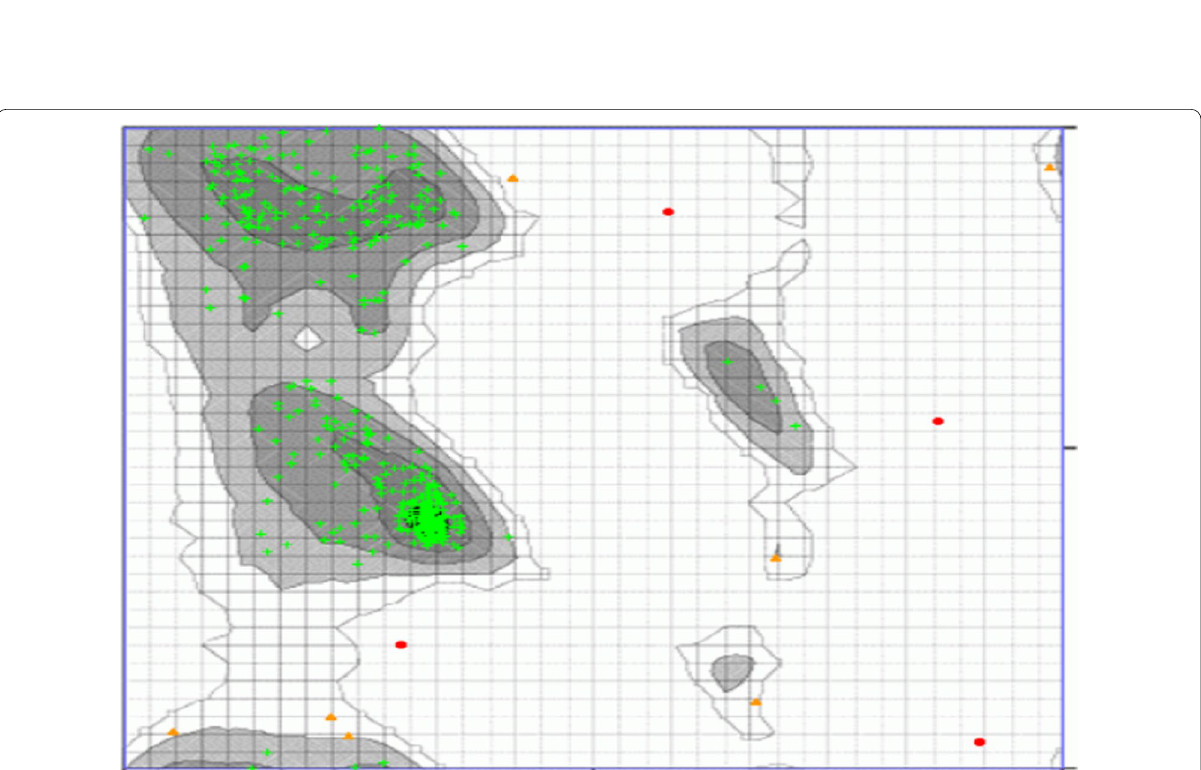
Fig. 5 G. mellonella CAT protein structure by Ramachandran plot with 97% of amino acids (https:// zlab. umass med.